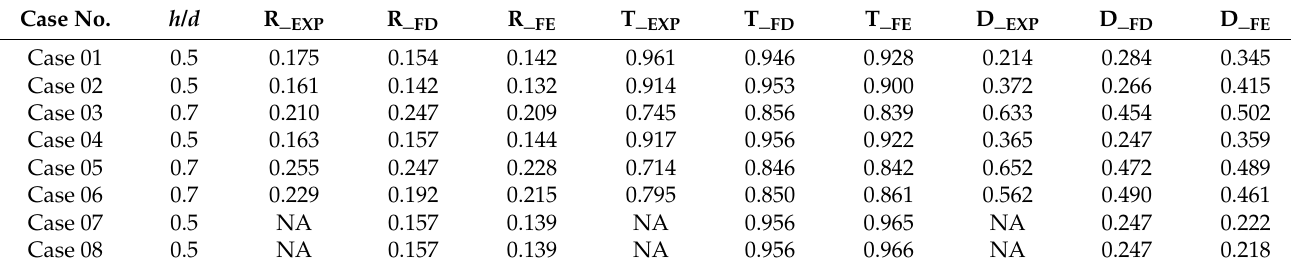
Table 2. Summary of computed coefficients for the reflected ( R ) and transmitted ( T ) waves, and the dissipation ( D ). Case